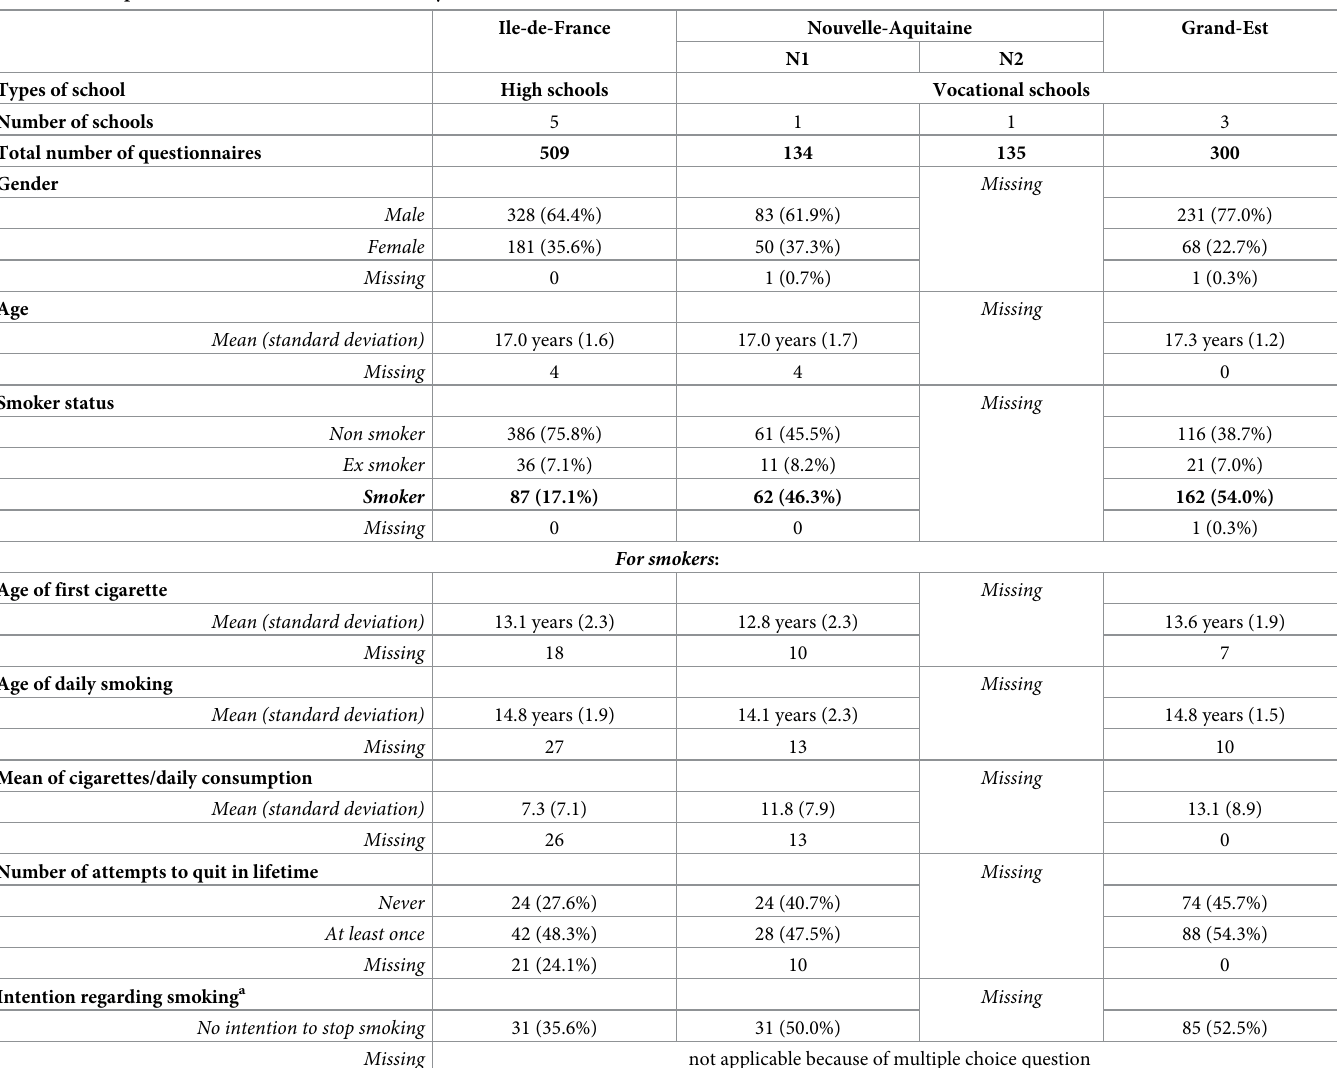
Table 2. Description of the cases included in the